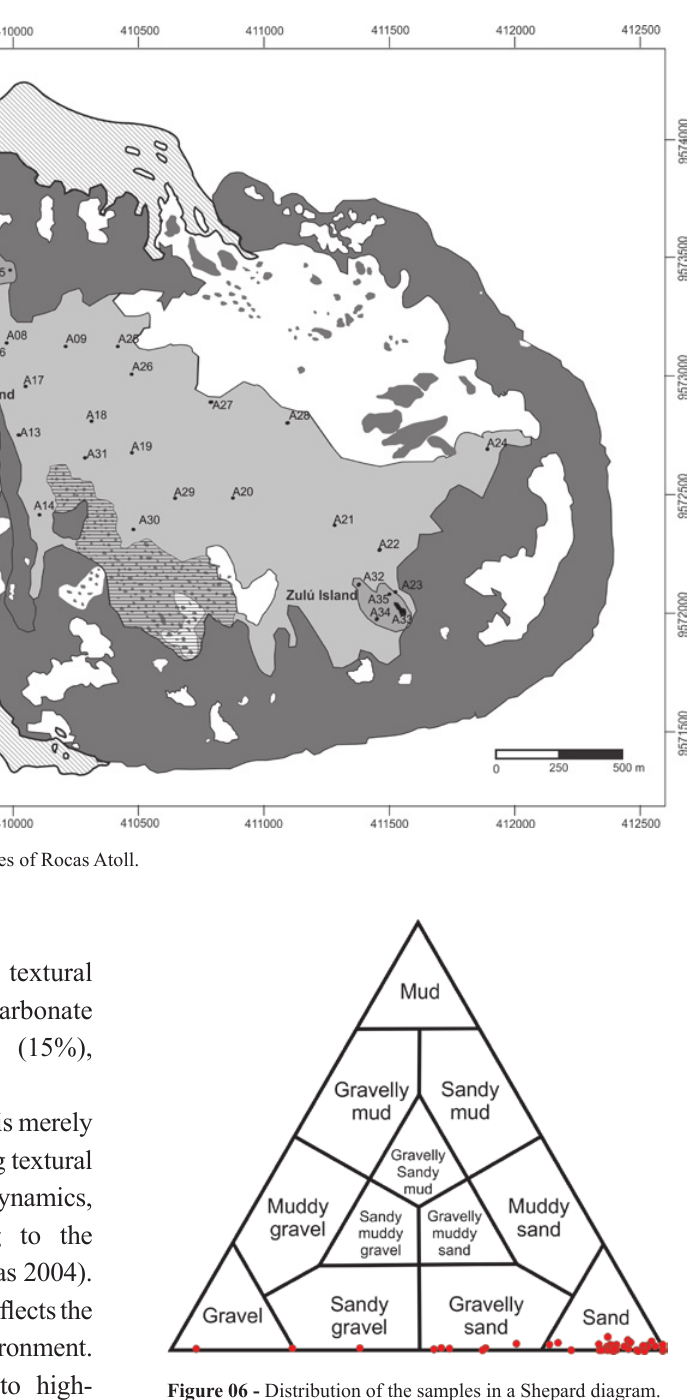
Figure 06 - Distribution of the samples in a Shepard